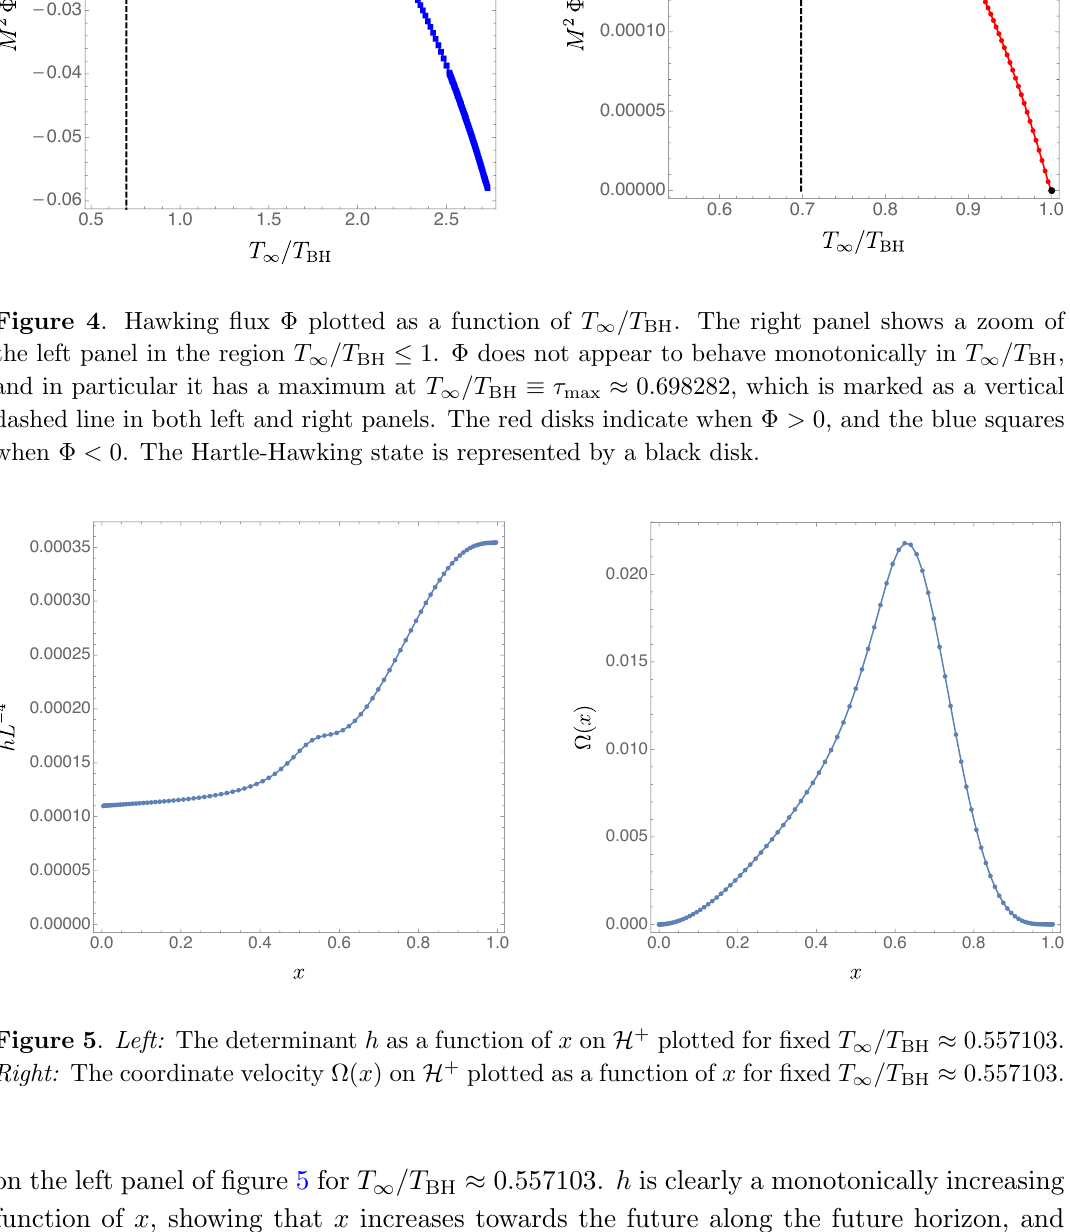
on the left panel of (cid:12)gure 5 for T